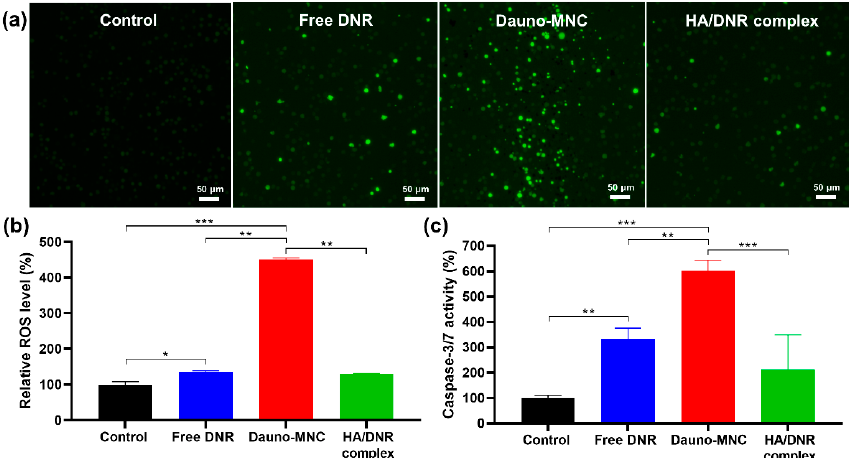
Figure 7. ( a ) Representative CM-H 2 DCFDA staining images of HL-60/MX2 cells treated for 1 h with Dauno-MNC, HA/DNR complex and free DNR at a final DNR concentration of 1.6 µM. ROS- generating cells showed green fluorescence. Scale bar = 50 µm. ( b ) Relative ROS levels of HL-60/MX2 cells that received the same treatment as those in ( a ). ( c ) The effect of different treatments on the caspase-3/7 activity of HL-60/MX2 cells after 1 day of incubation. Mean ± SD ( n = 6); * p < 0.05; ** p < 0.01; *** p <